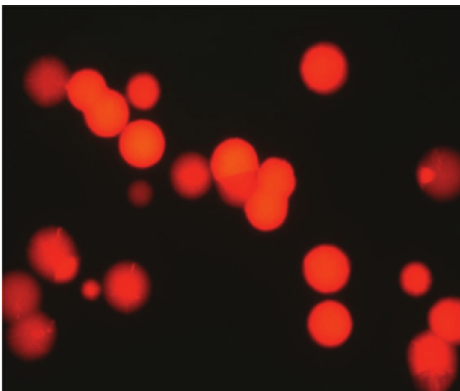
Figure 6: dsRED expression in the SP Δ asd mutant (pYA3334- dsRED). SP Δ asd mutant (pYA3334-dsRED) colonies showed red fluorescence on LB plates without DAP.